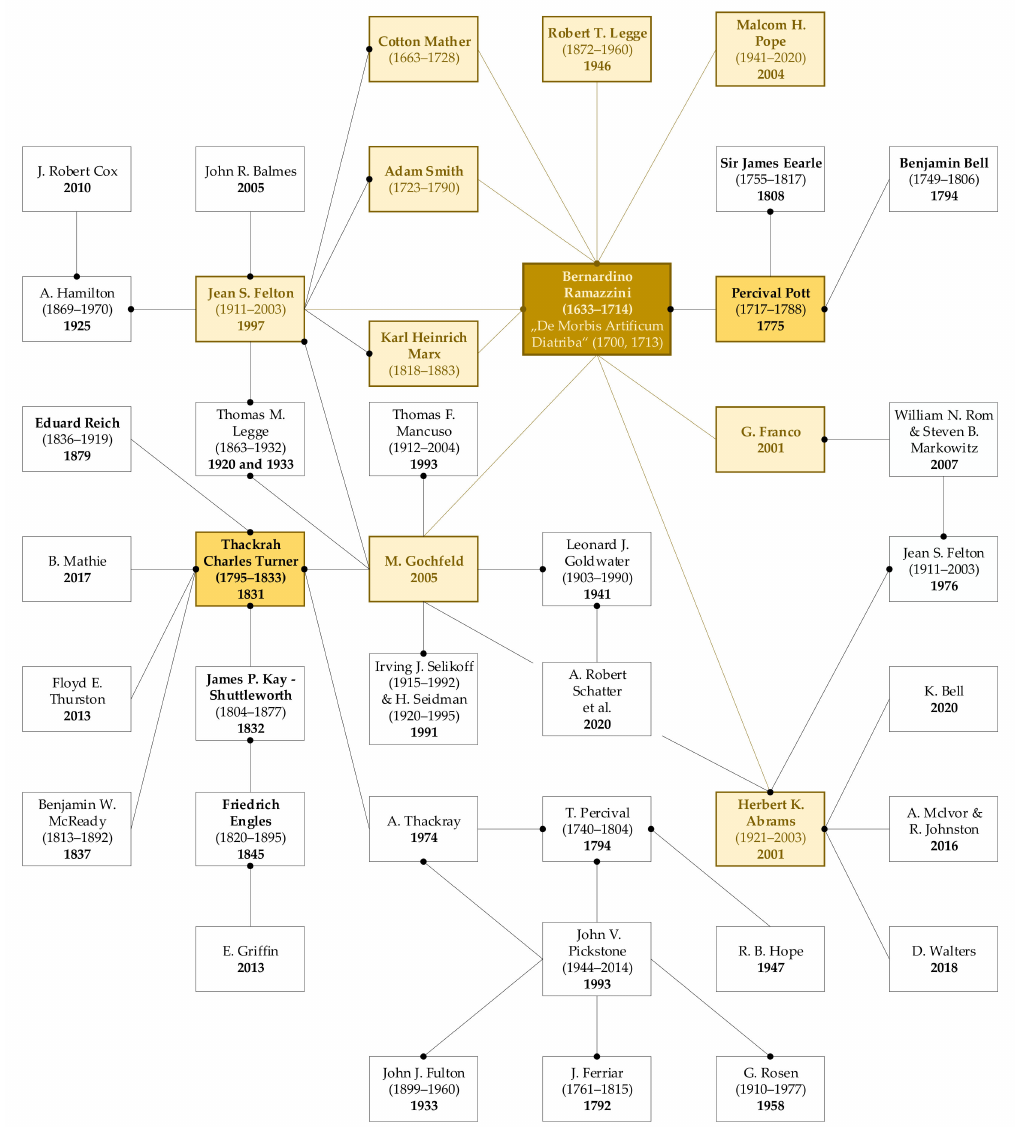
Figure 3. Map of articles in the field of occupational medicine starting with B. Ramazzini [Source: